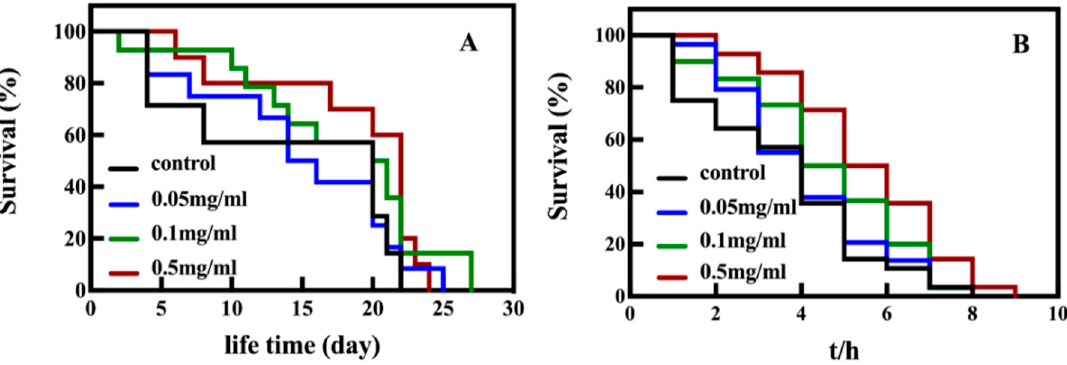
Figure 1. Impact of SPO on lifespan of C. elegans ( A ). Impact of SPO on lifespan of C. elegans treated with 200 μ M juglone ( B ).